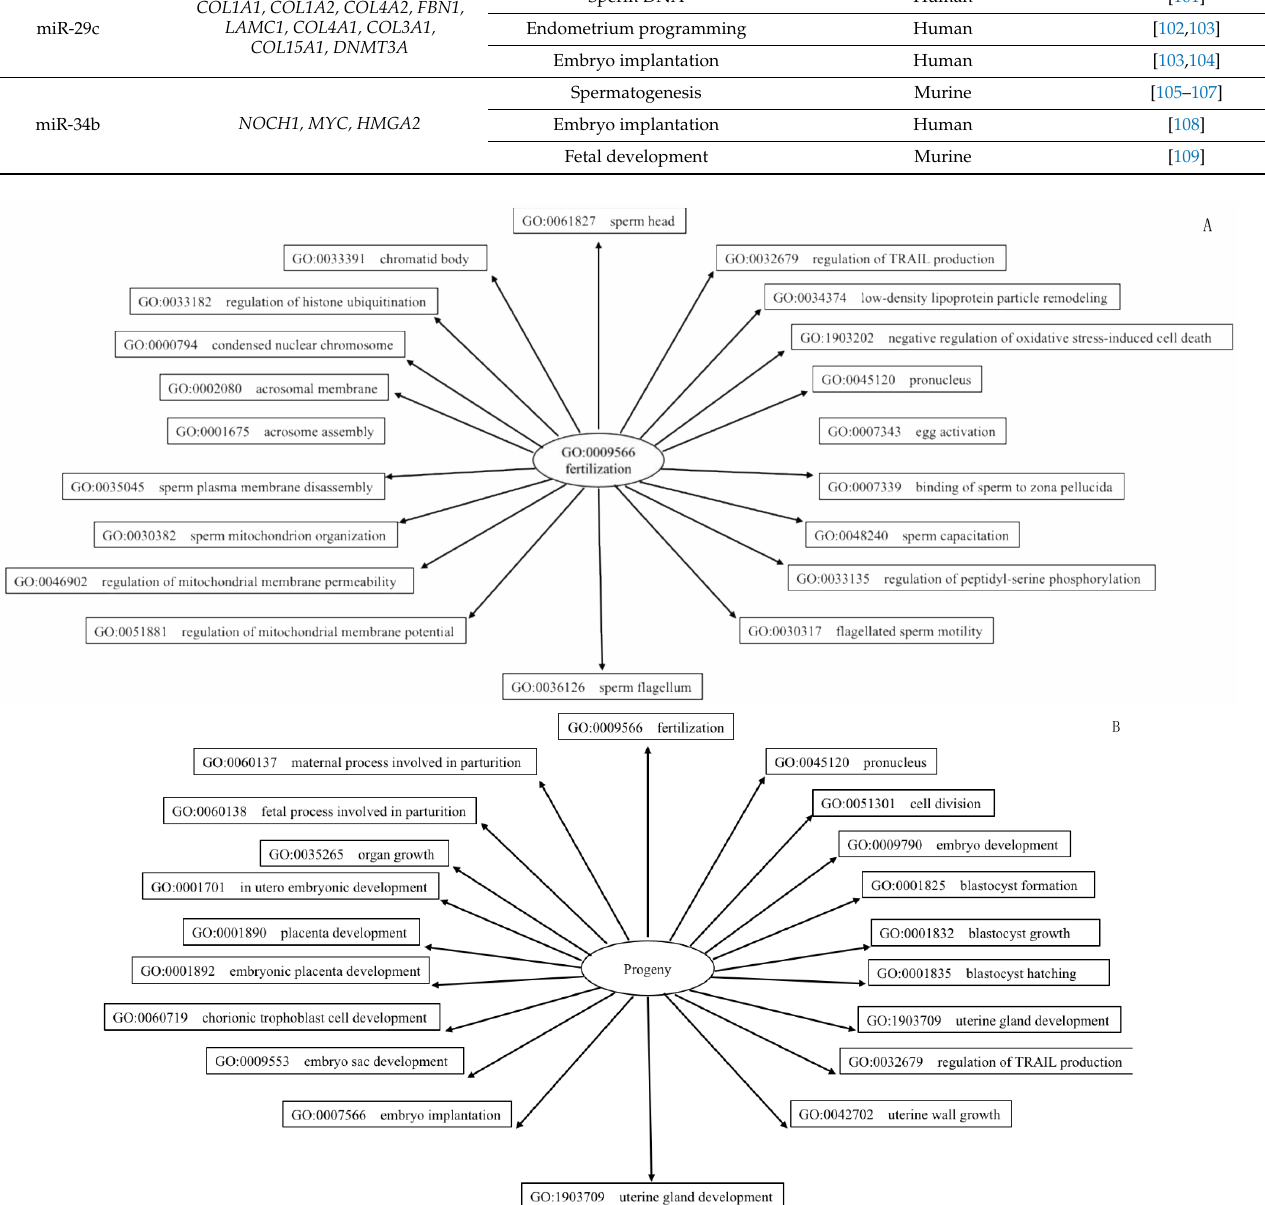
Figure 6. ( A ) Selected QuickGo gene ontology term and its co-occurring terms predicting processes involved fertilization. Note: GO terms male organ development and fertilization predicted from Database for Annotation, Visualization and Integrated Discovery (DAVID 6.8) bioinformatics analysis for differentially expressed miRNAs both in high-fertile sperm and seminal plasma were used for prediction of co-occurring QuickGO terms. ( B ) Selected QuickGo gene ontology term and its co-occurring terms predicting processes involved progeny development. Note: GO terms embryo, trophoblast, and organ development predicted from Database for Annotation, Visualization and Integrated Discovery (DAVID 6.8) bioinformatics analysis for differentially expressed miRNAs both in high-fertile sperm and seminal plasma were used for prediction of co-occurring QuickGO terms.